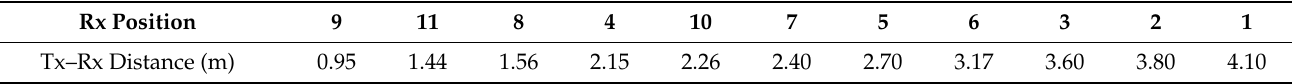
Table 2. Distances between transmitting and receiving antennas for each Rx